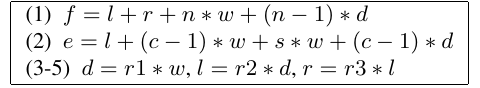
Table 1: Constraints that characterize a row of windows the distances l and r between the facade margin and the leftmost and rightmost window, respectively (see equation (1) in table 1).